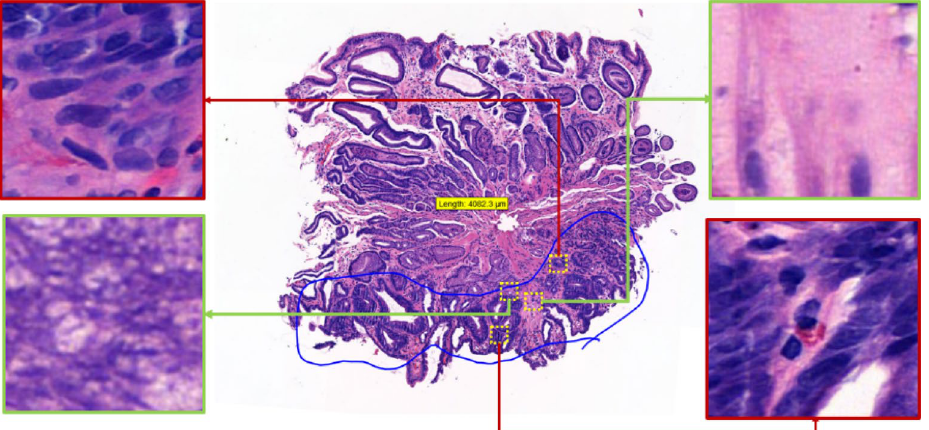
Figure 1. The portion of the tissue circled in blue is a dysplasia annotation by a professional pathologist. The red zoomed-in regions are abnormal (true positive) regions within the annotation and the green zoomed-in regions are normal, benign (false positive) regions within the